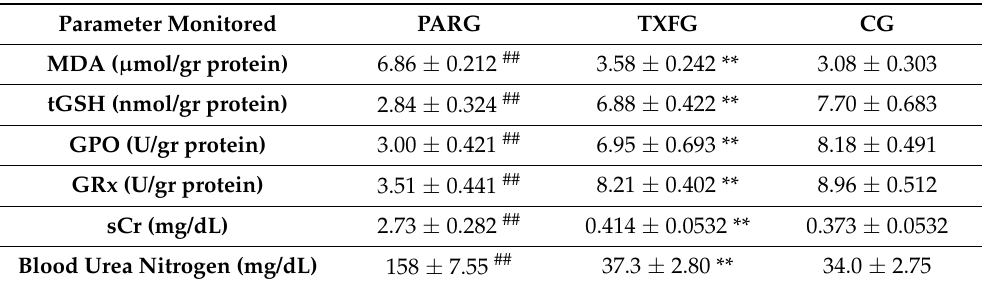
Table 1. Levels of Malondialdehyde (MDA), total Glutathione (tGSH), Glutathione peroxidase (GPO) and Glutathione reductase (GRx) monitored in renal tissues samples, serum Creatinine (sCr) and blood urea nitrogen (BUN) from the Paracetamol group (PARG), the Taxifolin group (TXFG) and the Control (CG).